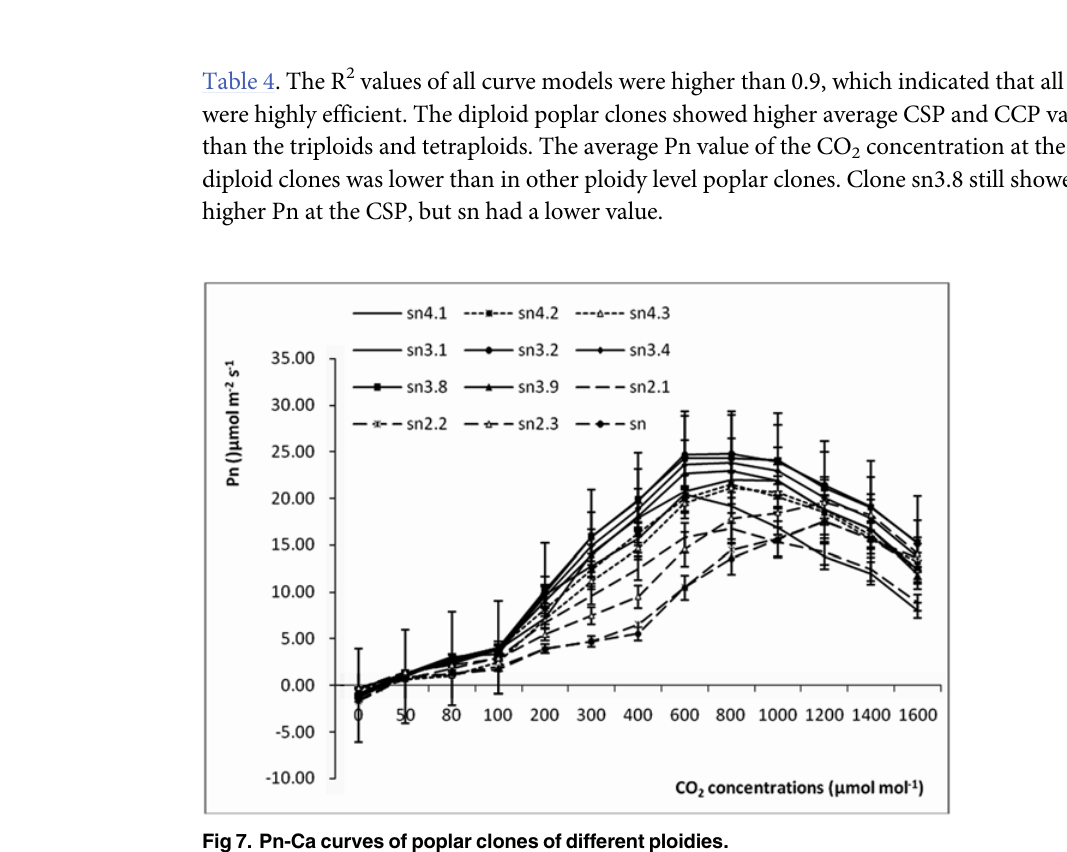
Fig 7. Pn-Ca curves of poplar clones of different